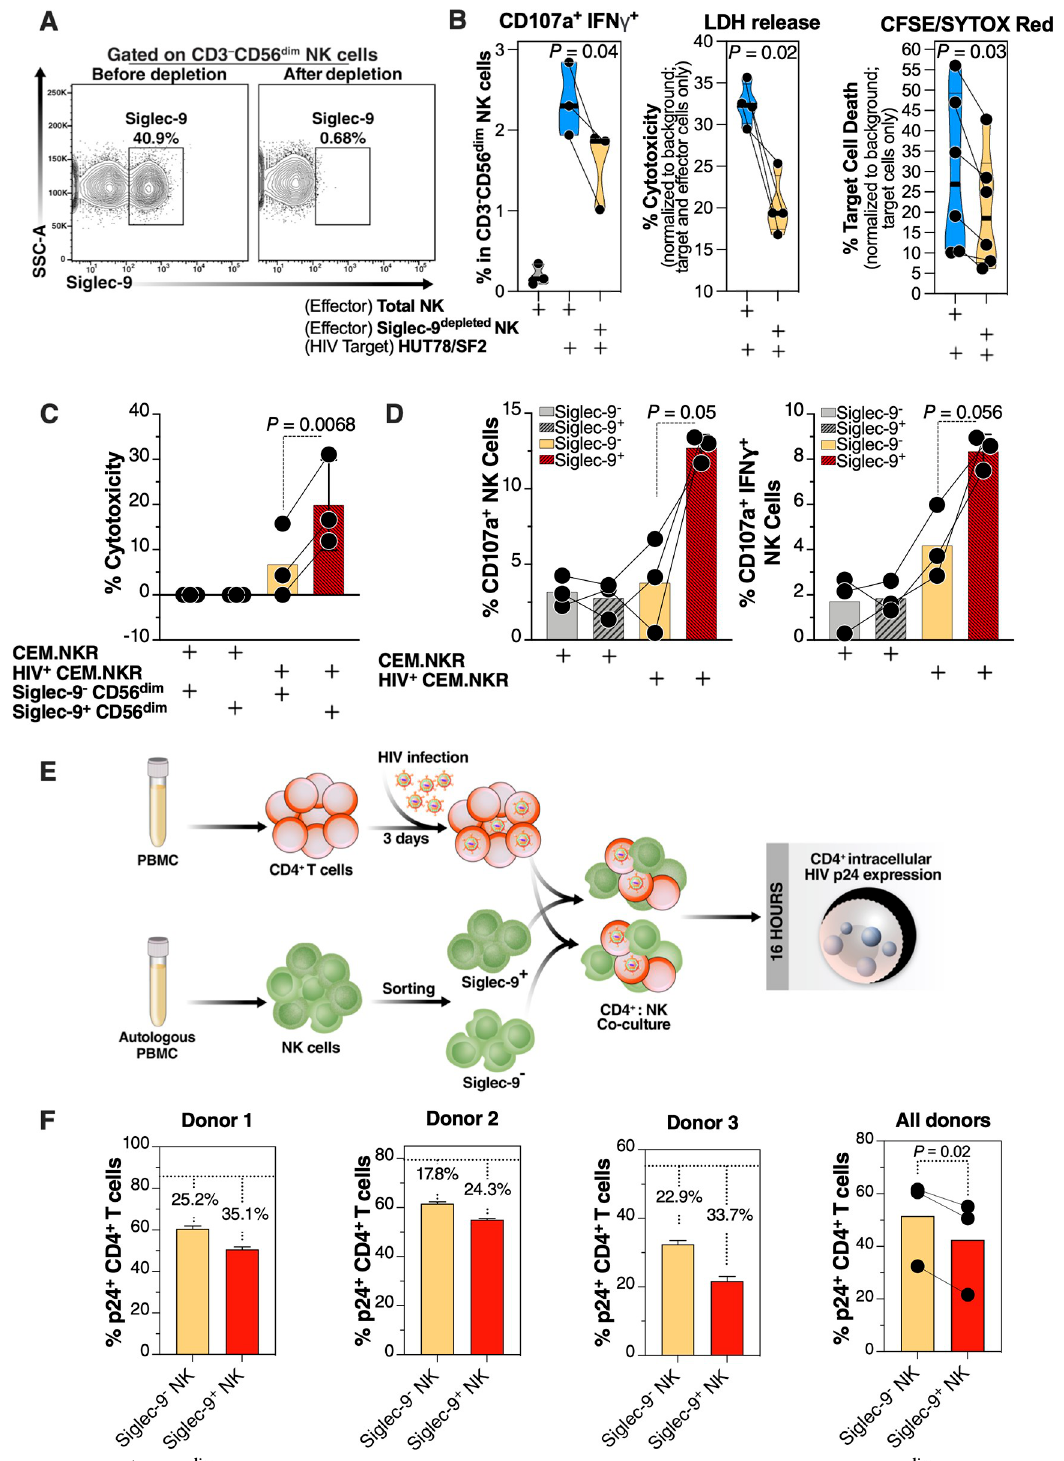
Fig 4. Siglec-9 + CD56 dim NK cells exhibit higher cytotoxicity towards HIV+ cells compared to Siglec-9 - CD56 dim NK cells. (A) A representative example of depletion of Siglec-9 + NK cells. (B) Siglec-9 depleted NK cells exhibit lower cytotoxicity towards HIV- infected HUT78/SF2 targets compared to total NK cells. Cytotoxicity was assessed using NK degranulation, left panel (n = 3 donors; E:T = 4:1), LDH release, middle panel (n = 4 donors; E:T = 10:1), and CFSE/SYTOX Red assay, right panel (n = 6 donors; E: T = 10:1). NK degranulation measured as CD107a + IFN γ + . Assays from each donor were performed in 2–4 replicates, and the